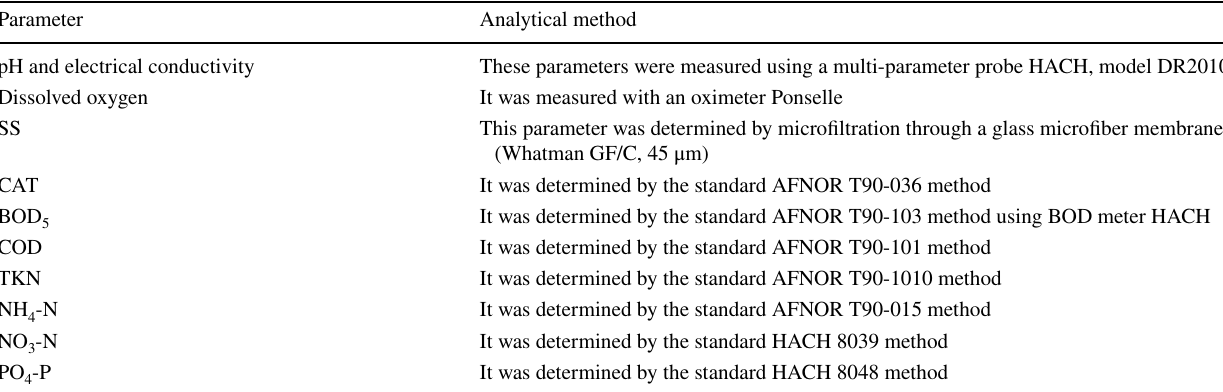
Table 1 Analytical methods used in this study Parameter